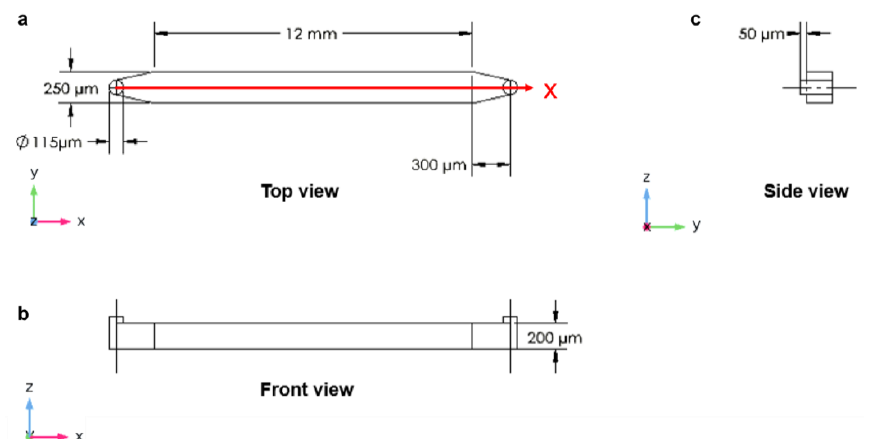
Figure 2. The longitudinal microchannel: ( a ) top view; ( b ) front view; ( c ) side view (D = diameter).